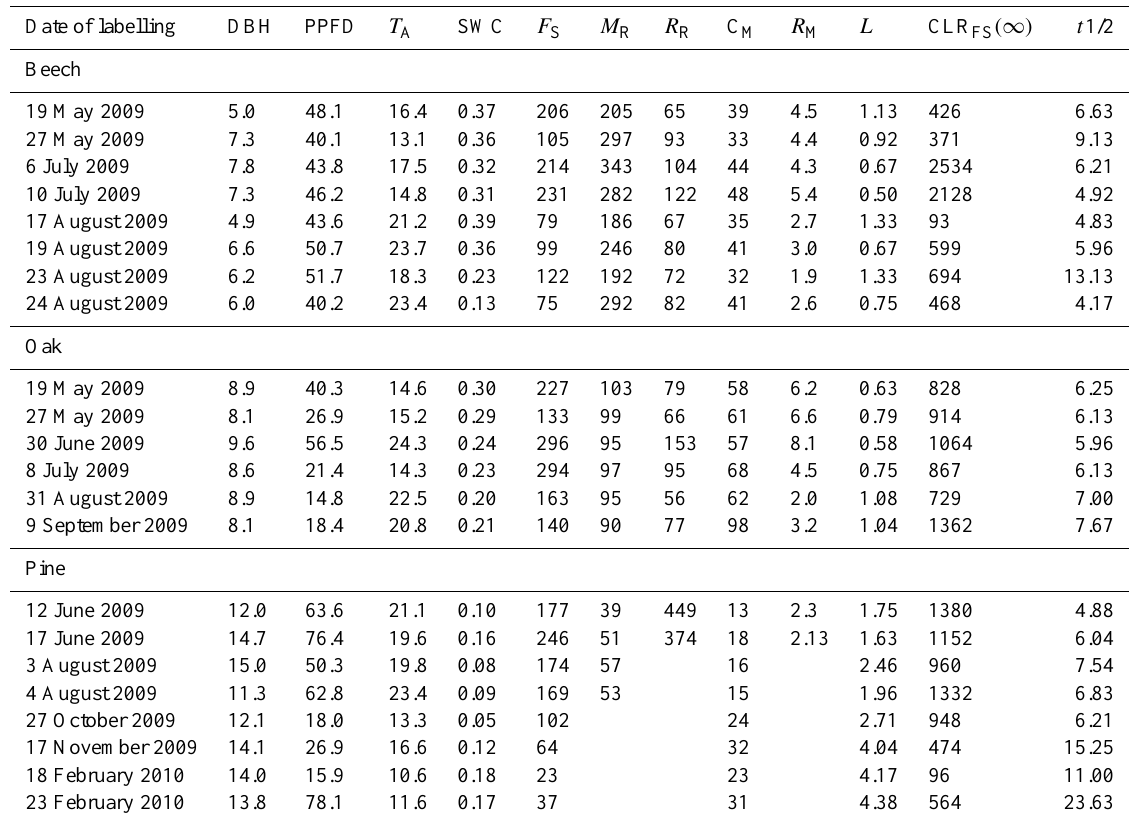
Table 1. Diameter at 1.3m height (DBH, cm), cumulative photosynthetic photon flux density (PPFD, molm − 2 d − 1 ) over 24h following the beginning of labelling, air temperature ( T A , ◦ C) averaged over 24h following the beginning of labelling, volumetric soil water content (SWC, m 3 m − 3 ) on the day of labelling. Soil CO 2 efflux ( F S , mgCm − 2 h − 1 ) , root mass per unit area ( M R , gDMm − 2 ) , specific root respiration ( R R , mgCkg − 1 h − 1 ) , microbial carbon per unit area (C M , gCm − 2 ) and microbial respiration ( R M , mgCkg − 1 DM the entire chase period (20 days). Time lag in 13 C recovery in soil CO 2 efflux ( L , day), asymptotic value of cumulative label recovered in soil CO 2 efflux (CLR FS ( ∞ ) in mg 13 C) and half residence time ( t 1/2, day) were estimated by fitting cumulative label recovered in soil CO 2 efflux to Eqs.